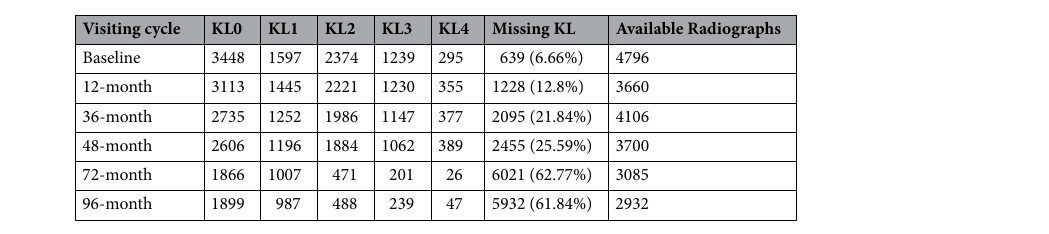
Table 5. Distribution of KOA severity levels in the OAI